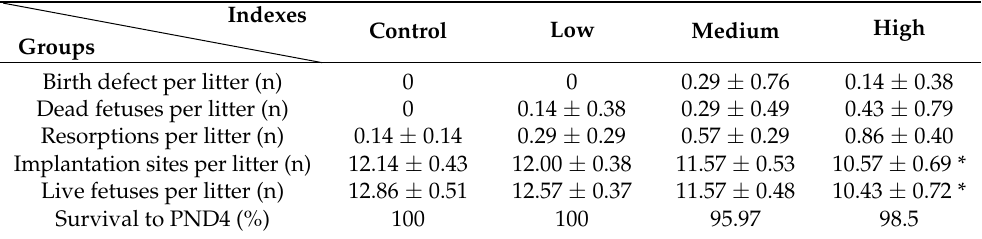
Figure 1. Effects of gestational cyfluthrin exposure on maternal weight, fetal weight, and length. Pregnant rats were administered corn oil or different doses of cyfluthrin (6.25, 12.5, or 25 mg/kg) daily in pregnancy. ( A ) Maternal weight. ( B ) Fetal weight. ( C ) Crown-rump length. Values are expressed as the mean ± SE. The result was analyzed with one-way ANOVA followed by Dunnet’s t -test. * P < 0.05, ** P < 0.01 compared to controls. Table 1. Effects of gestational cyfluthrin exposure on fetal outcomes and fetal development (mean ±